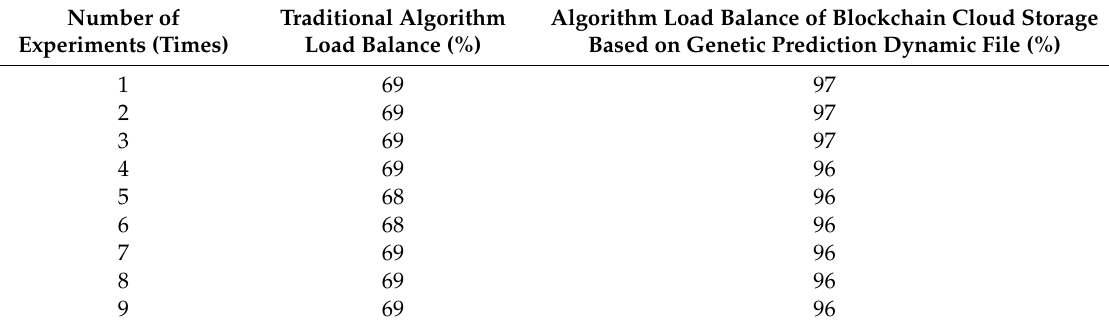
Table 3. Cloud storage system load